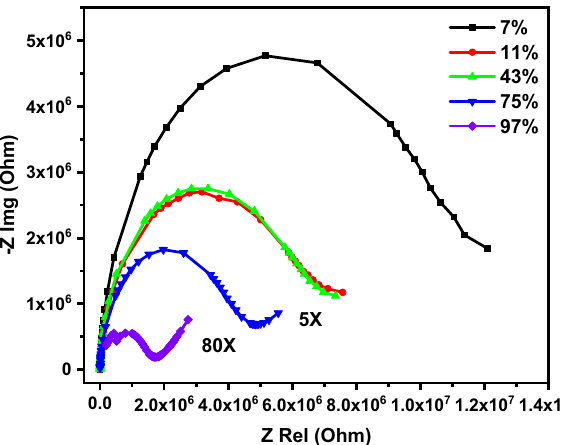
Figure 17. The Nequest plot of GQDs at different humidity levels from 50 up to 5